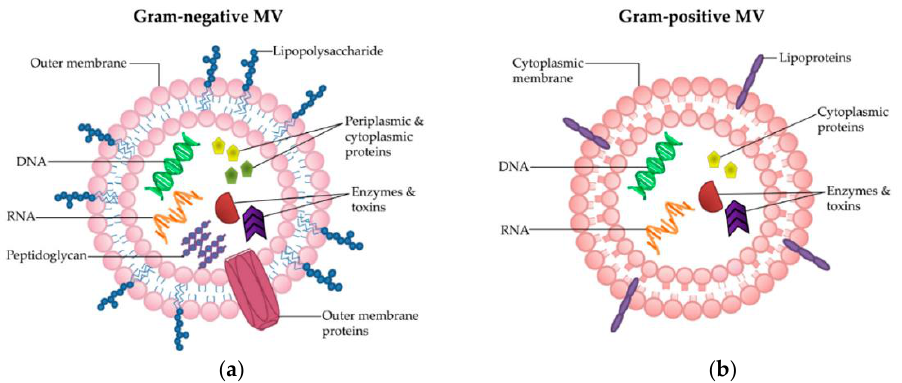
Figure 6. Cell wall compositions of ( a ) Gram-negative and ( b ) Gram-positive bacteria. Preprinted from [141], originally published under a CC-BY 4.0 license.